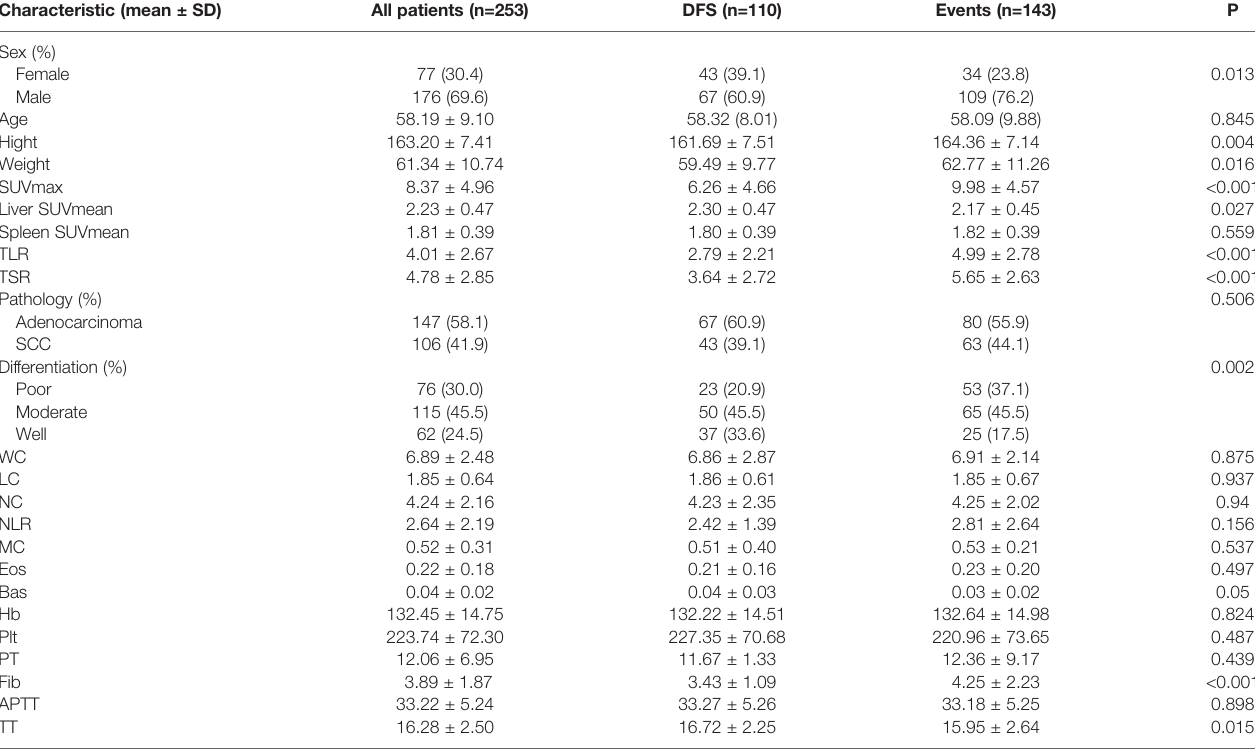
TABLE 1 | Comparison of the basic characteristics of patients with an event and patients with disease-free survival. Characteristic (mean ± SD)